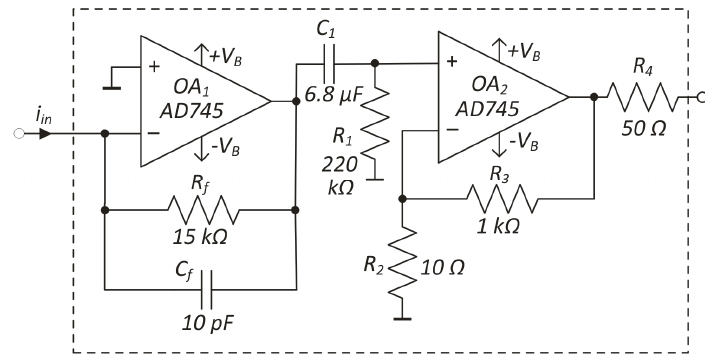
Figure 4. Scheme of a single channel of the designed read-out electronics.